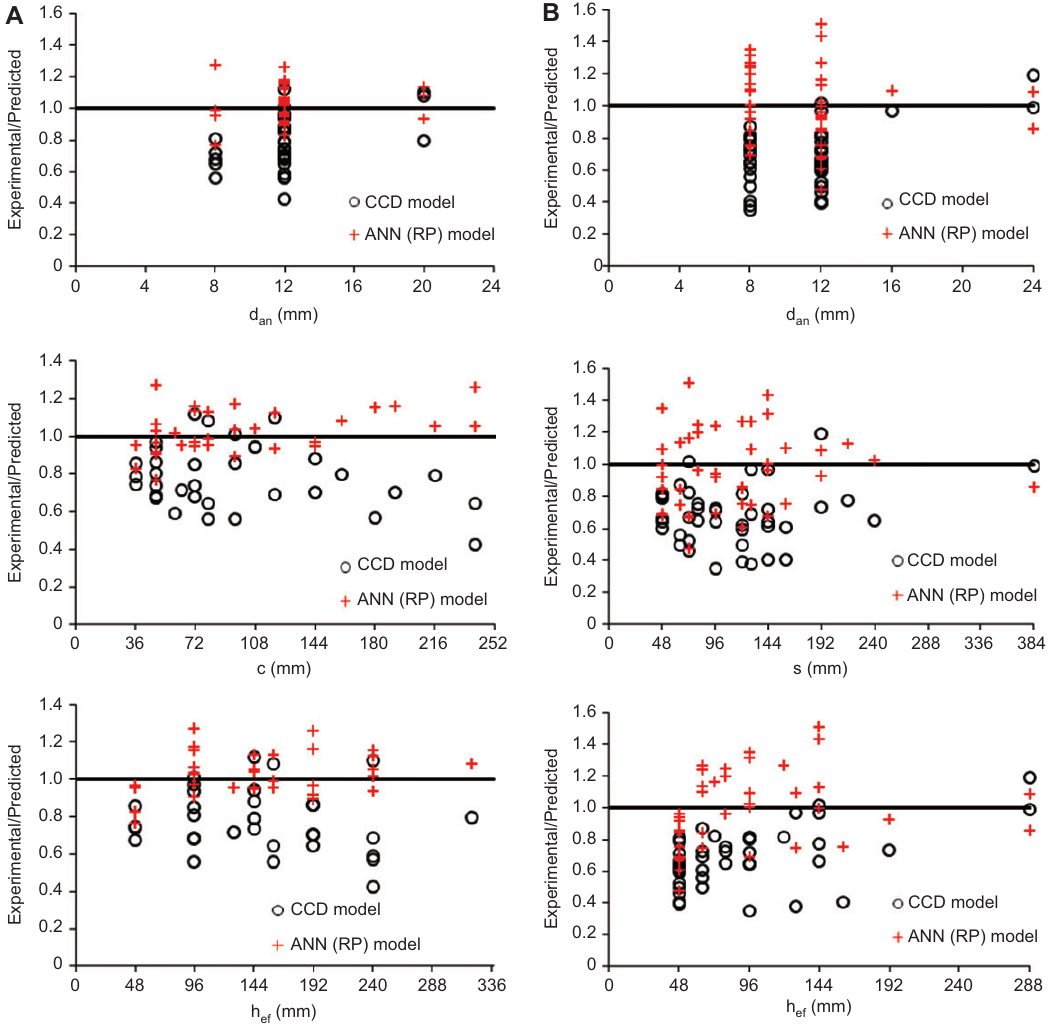
Figure 10 Prediction performance of the ANN and CCD methods for testing data depending on the main parameters (A) single anchor, (B) group